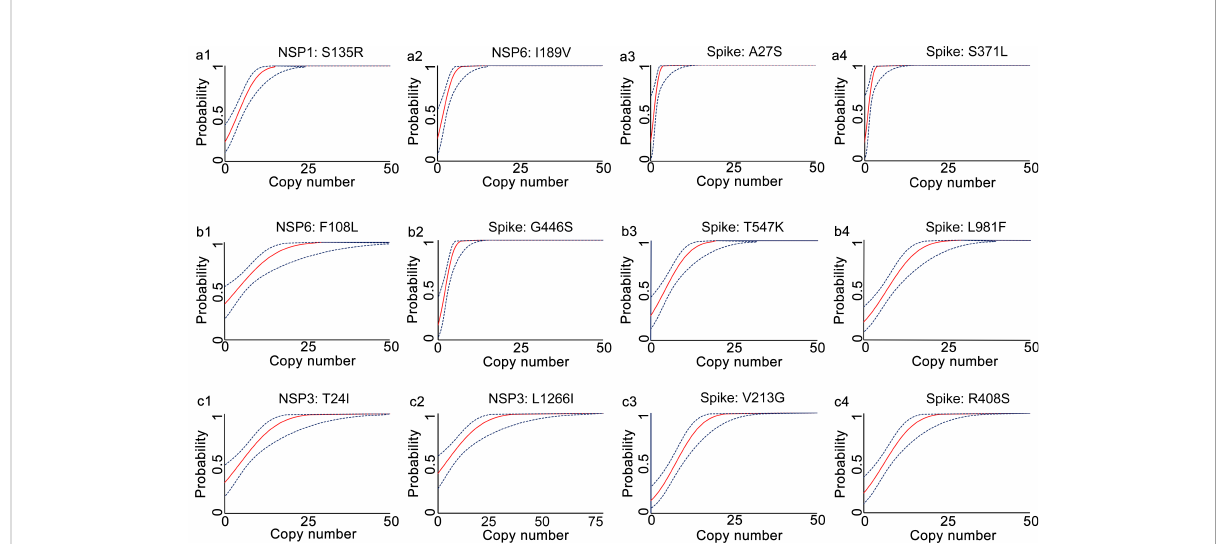
FIGURE 3 Determination of limits of detection for the developed multiplex allele-speci fi c qRT-PCR assays to detect the Mutated RNA of SARS-CoV-2. Limits of detection (LoDs) for the developed qRT-PCR assays to the mutated RNA (covering all the alleles in Table 1) of SARS-CoV-2 were determined by the Probit Regression (Dose-Response analysis) implemented in SPSS v22.0. qRT-PCR was performed by using the in vitro transcribed mutated RNA (2-fold dilution from 200 copies/reaction to 0.1 copies per reaction) as templates. The obtained Cp values and the corresponding copy number of viral RNA were applied for Probit Regression analysis. Probit curves for assay 1 [NSP1: S135R (a1), NSP6: I189V (a2), Spike: A27S (a3), and Spike: S371L (a4)], assay 2 [NSP6: F108L (b1), Spike: G446S (b2), Spike: T547K (b3) and Spike: L981F (b4)], assay 3 [NSP3: T24I (c1), NSP3: L1266I (c2), Spike: V213G (c3), and Spike: R408S (c4)] are shown. The inner solid line (in red) is a Probit curve. The outer dotted lines (in dark blue) are 95%